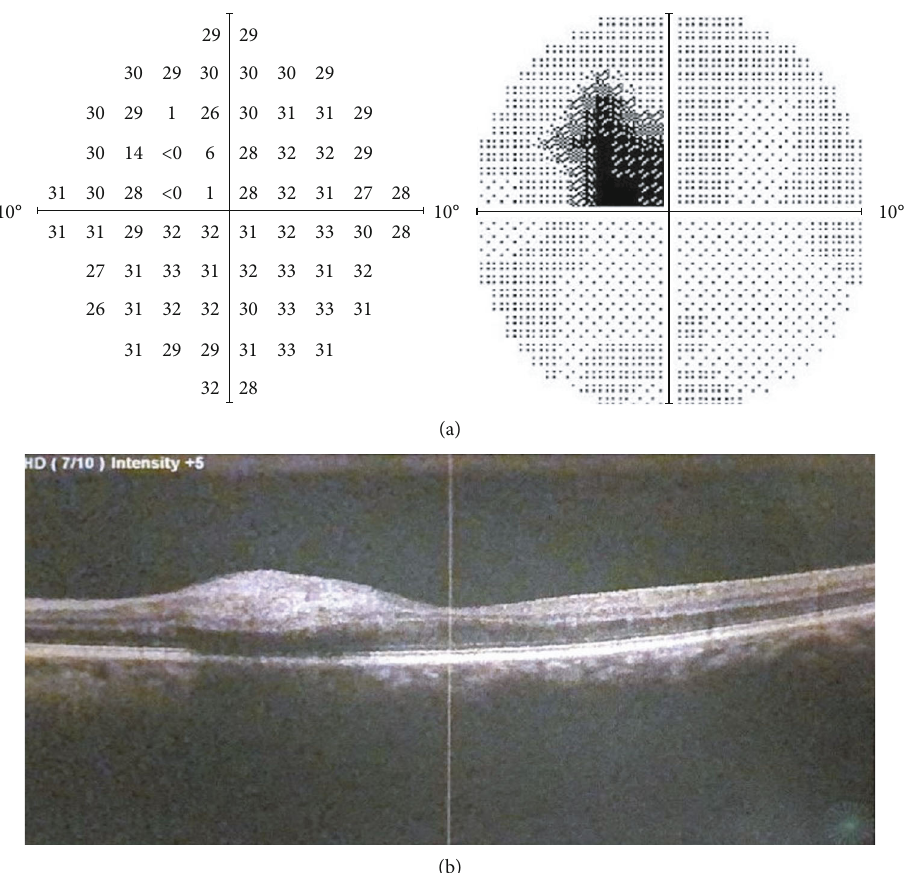
Figure 3: (a) Visual fi eld examination demonstrating defects in the 5 ° temporal in the left eye. (b) Optical coherence tomography (OCT) images of the left eye showing temporal inner layer